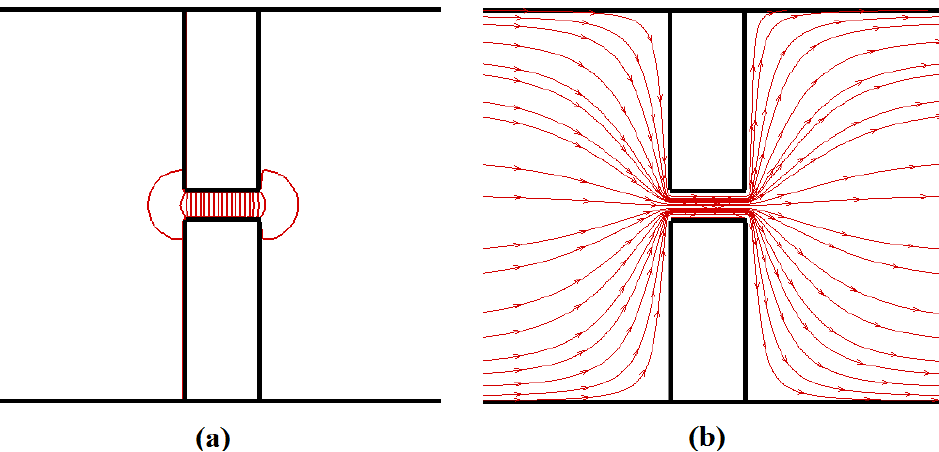
Figure 3. Solution of the Laplace equation for the potential around a 100 nm long nanopore: ( a ) electric potential and ( b ) electric field at the central yz